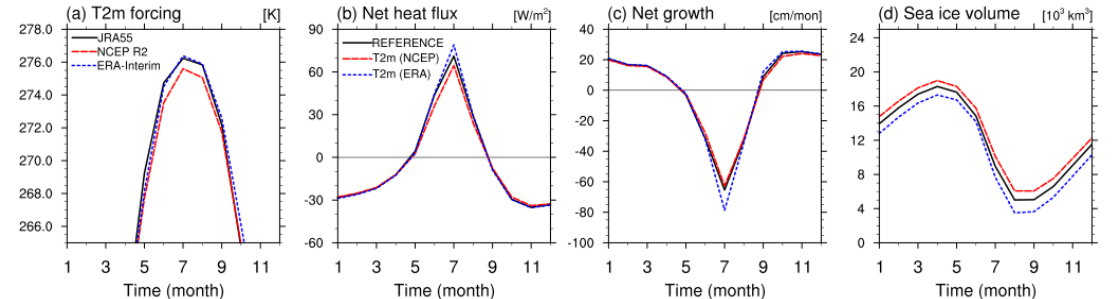
Figure 5. Comparison of the T2m experiments. ( a ) 2-m-temperature forcing (similar to Figure 1c but focused on summer), ( b ) net heat flux, ( c ) net growth rate of sea ice, and ( d ) sea ice volume. ( c , d ) use the same labels as ( b ).